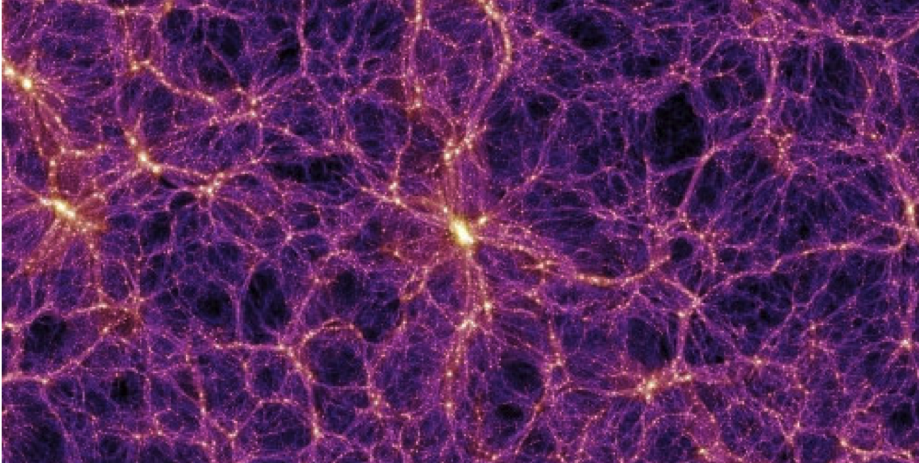
Figure 2. The structure of the intergalactic medium can be illustrated by the Millennium simulation [22]. This “cosmic web” consists of filaments of galaxies and empty desolate voids, which occupy the vast majority of the volume of the Universe. Measuring the elusive cosmic magnetic fields in this diffuse plasma is fundamentally dependent on the computationally-expensive technique of Faraday tomography, which can have similar computational overheads to de-dispersion for observations of